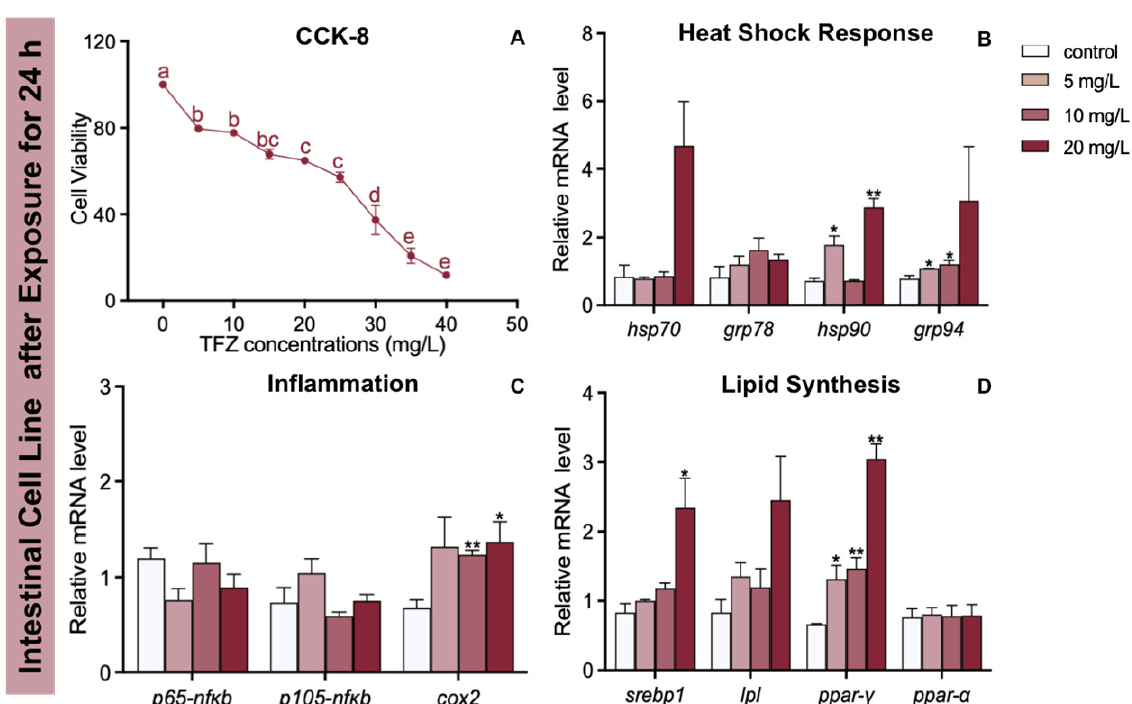
Figure 7. Effects of the fish intestinal cell line after triflumizole exposure for 24 h. ( A ) The cell viability. ( B ) The expression of hsp70 , grp78 , hsp90 , and grp94 after triflumizole exposure. ( C ) The expression of p65-nf κ b , p105-nf κ b , and cox2 after triflumizole exposure. ( D ) The expression of srebp1 , lpl , ppar- γ and ppar- α after triflumizole exposure. Data are expressed as the mean of three replicates ± standard error (SEM). Values without a common superscript letter differ ( p < 0.05, Tukey’s test). Asterisks denote significant differences between the control group and TFZ groups (determined by Dunnett post hoc comparison, * p < 0.05, ** p < 0.01).